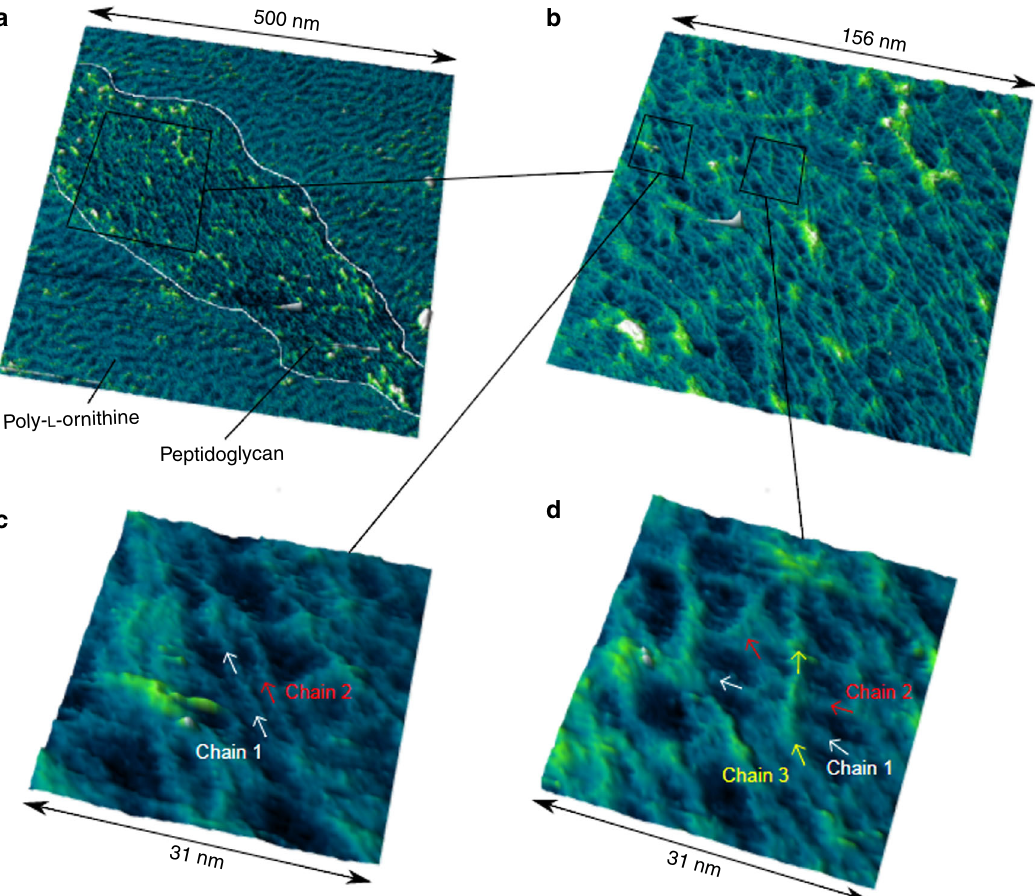
Fig. 1 Direct visualisation of glycan strand arrangement in the E. coli polymer envelope by AFM. a 3D representation of a peptidoglycan fragment mounted on poly- L -ornithine (see annotations). b Higher resolution image of boxed region in a . Long glycan chains are visible. c Zoom of marked boxed region in b showing side-by-side chains. d Zoom of marked boxed region in b showing overlapping